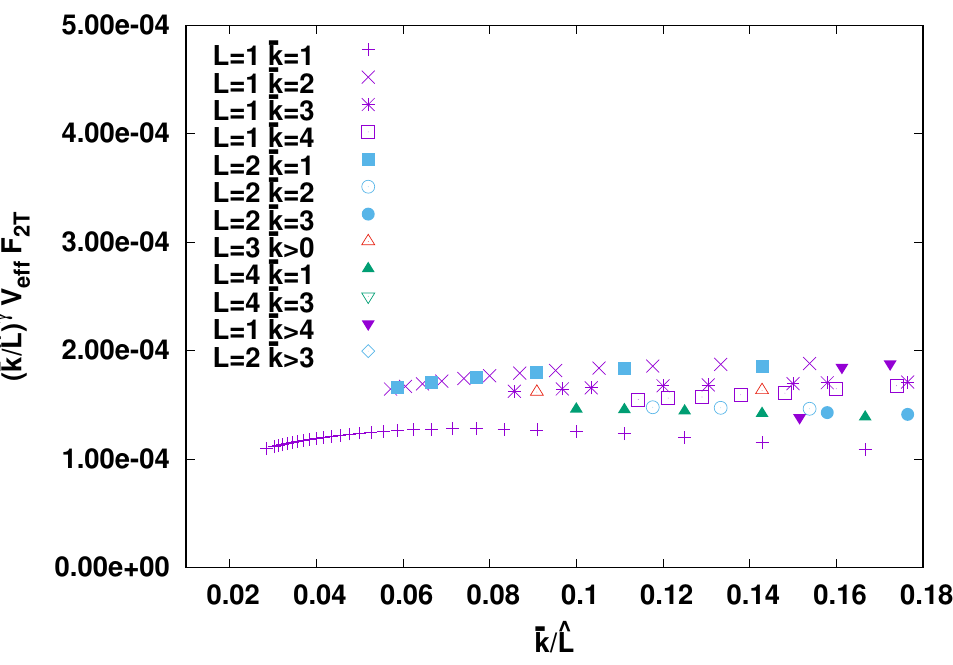
Figure 4. Behaviour of F 2 T for small values of (cid:22) k= ^ L .